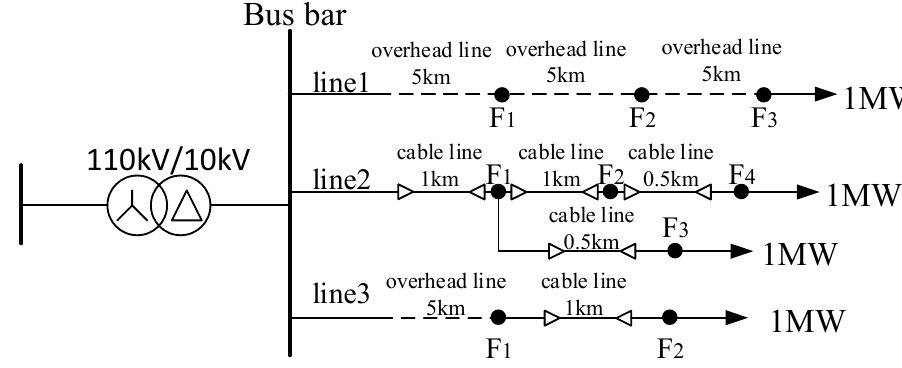
Figure 23. Experimental model of the dynamic fault simulation system. Table 8. Line selection results under the conditions of the dynamic simulation fault diagnosis ex- perimental platform.